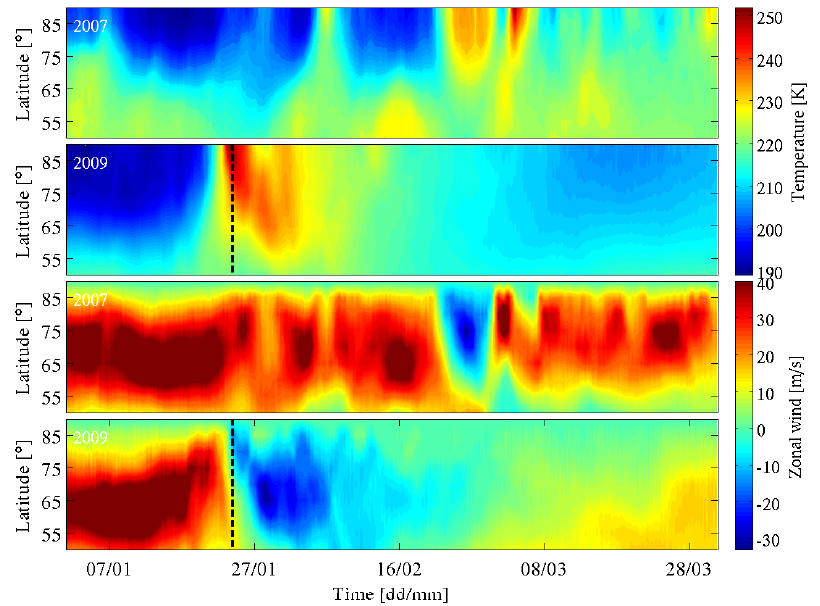
Fig. 3. ECMWF zonal mean temperature (K) and zonal mean zonal wind (ms − 1 ) at 10hPa ( ≈ 30km) as a function of time and latitude. The vertical black dashed lines in figures representing the year 2009 show the date when the criteria for the major SSW were